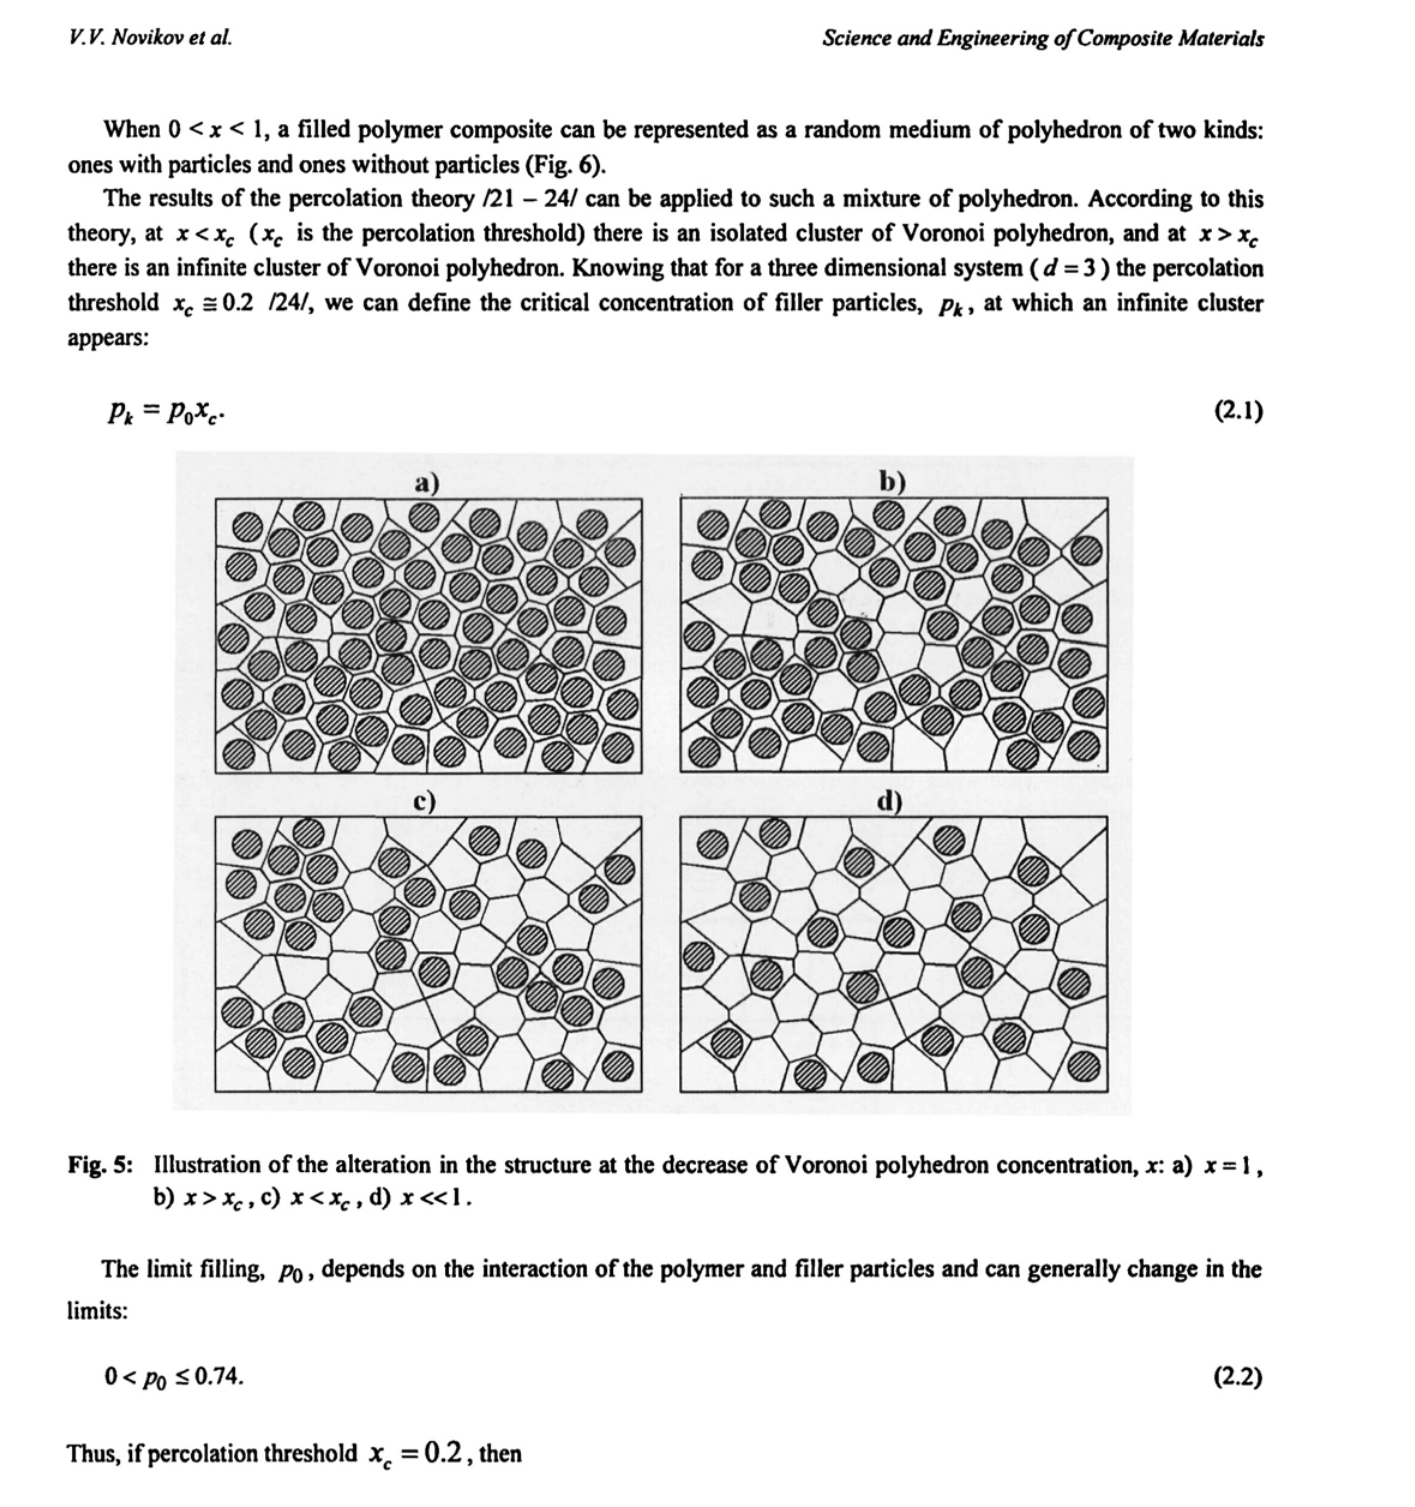
Fig. 5: Illustration of the alteration in the structure at the decrease of Voronoi polyhedron concentration, x: a) x = 1, , c) χ < x , d) χ « b) x> x c c